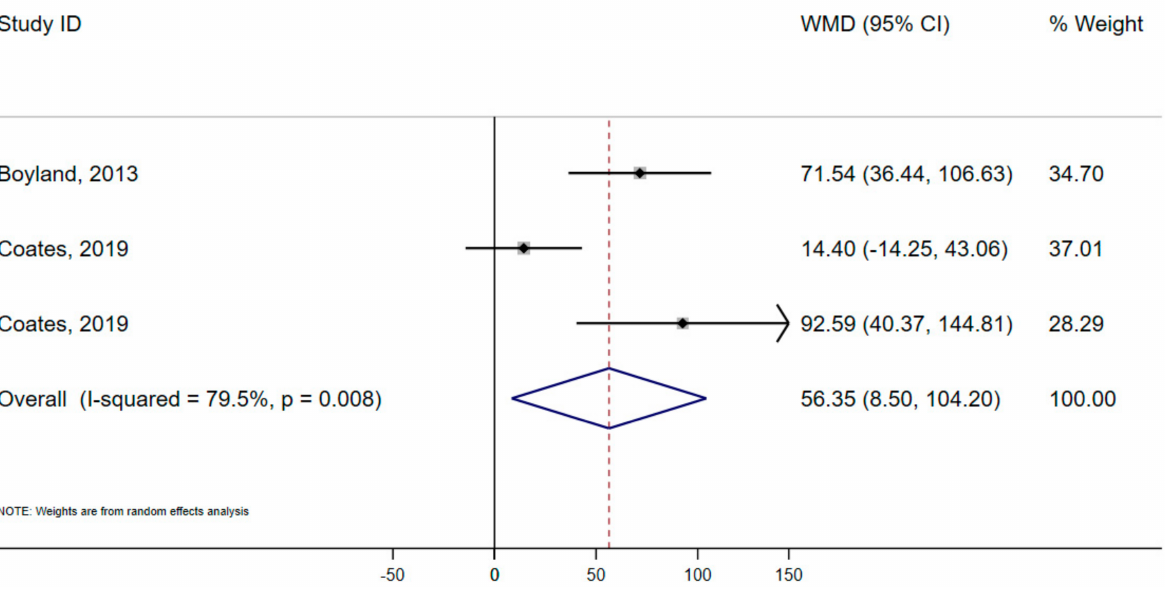
Figure 2. Forest plot showing mean difference (kcals) in total snack consumption of HFSS products between celebrity HFSS advertisement and non-food advertisement. Boyland, 2013; Coates, 2019; Coates,